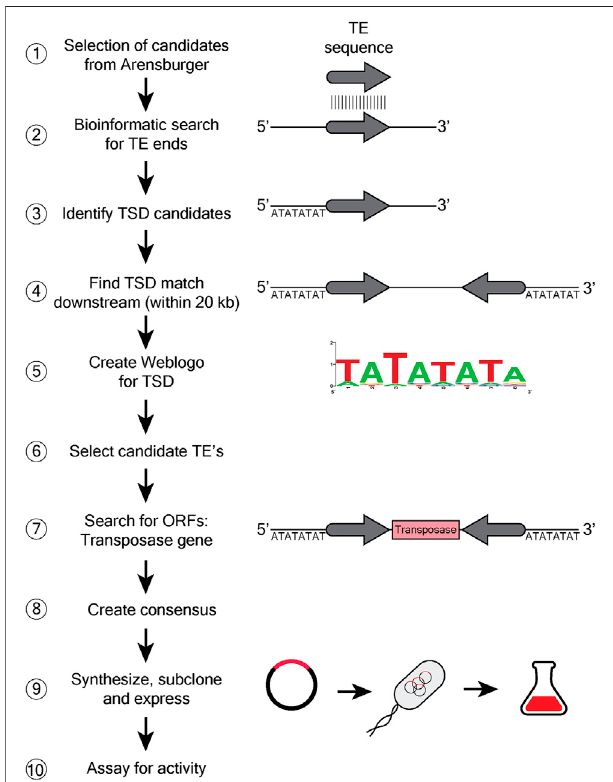
FIGURE 3 | Bioinformatic search for discovery of new transposases. A schematic 10 step fl ow chart describing the steps followed to capture candidate transposases with low consensus TSD. The diagrams show general DNA as a black line, with the grey arrow indicating the transposon end (TE) sequence. The 8 letter sequence indicates the target site duplication (TSD). The transposase ORF is shown as a box with transposase written in it. ① Data set from Arensburger with 299 currated TE ’ s of the hAT (hobo/Ac/Tam3)superfamily(Arensburgeretal.,2011)wasusedtosearchfor unique transposases. ② TE sequence is searched throughout the genomic DNA, to identify matching sequences. ③ Identi fi cation ofTSD sequences that wouldbedirectlyadjacenttotheTEsequence. ④ Identi fi cationoftheotherTE and TSD sequences downstream of the original. ⑤ Create a weblogo of TSD ⑥ and utilize the info to select for the appropriate TE ⑦ Identi fi cation of the transposase ORF within the transposon sequence. ⑧ A consenus sequence from homologs of the selected TE is created, ⑨ and the engineered synthetic TE is subcloned into an expression plasmid, transformed into E. coli and puri fi ed. ⑩ The puri fi ed TE is assayed for activity in vitro